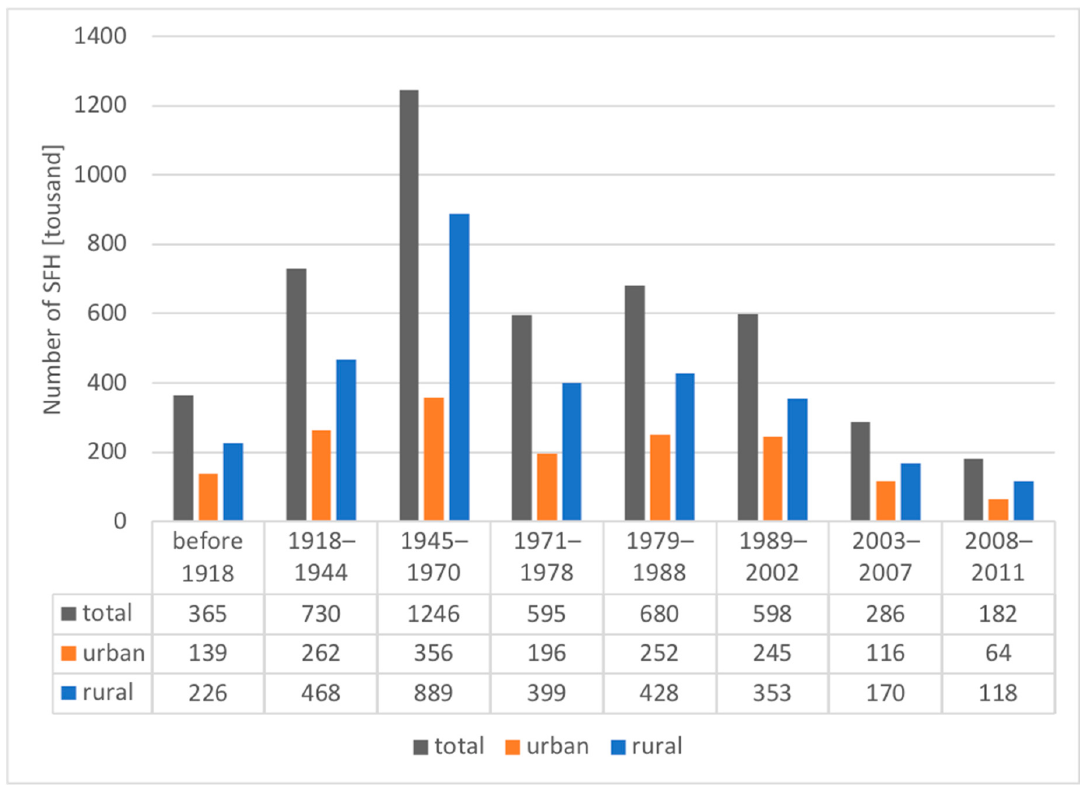
Figure 1. Single-family houses in Poland by construction period.